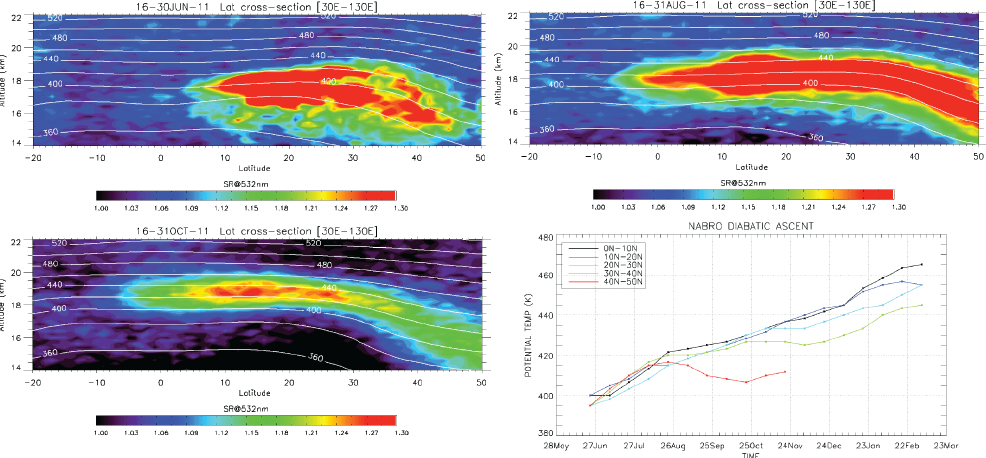
Figure 7. Latitude–altitude cross sections of mean cloud-cleared CALIPSO SR between 30 and 130 ◦ E for 16–30 June, 16–31 August, and 16–31 October, 2011. Isopleths of mean θ are also shown. Bottom-right panel: time series of θ corresponding to the peak in SR, June 2011–February 2012, for selected latitude bands (labeled).